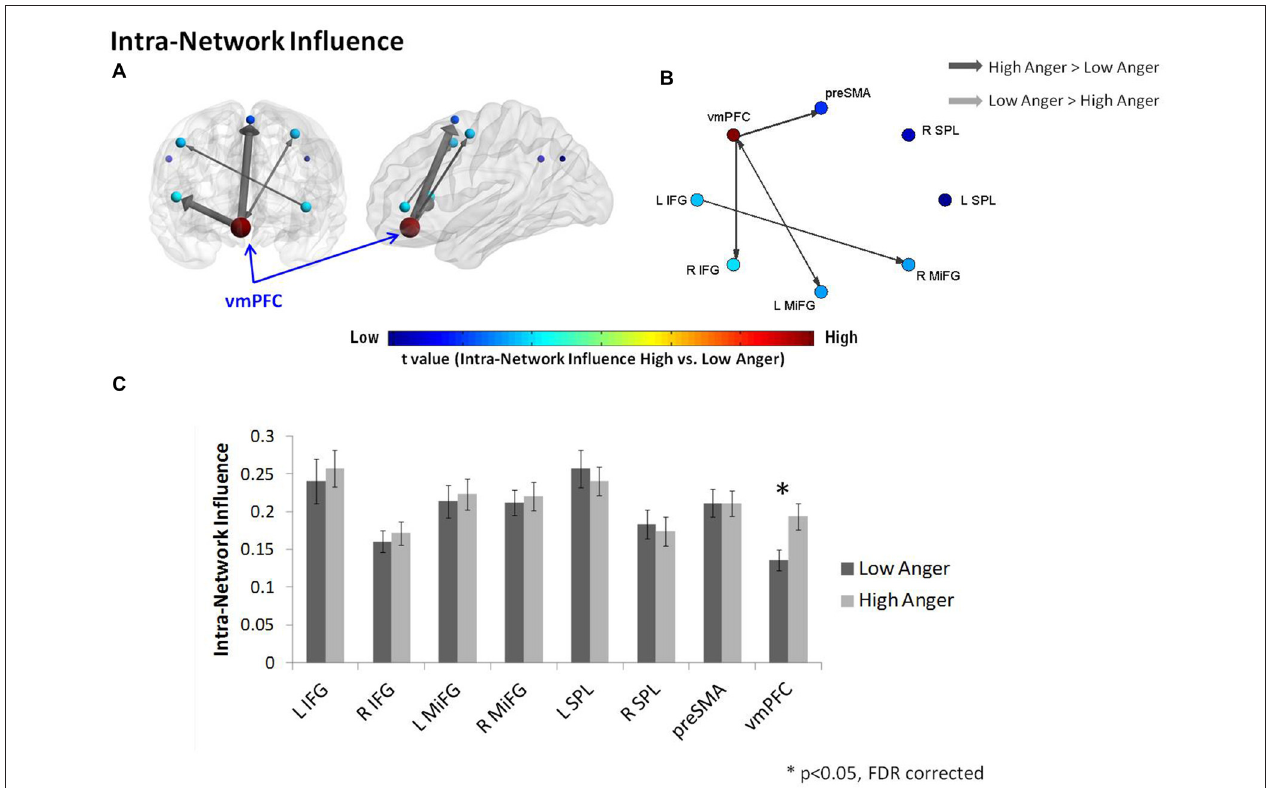
FIGURE 4 | Intra-regulation network results. The intra-network graph constructed for high anger minus low anger. The regulation network illustrated on sagittal and coronal views (A) and graphs visualization (B) . Each ROI was sized and color-coded according to its intra-network influence degree. Warmer colors and bigger sphere represent a more influential node. All pairwise ROIs with connections that were significant at the p < 0.05 level, using a t -test, are plotted as edges. The arrows indicate the direction of the influence, and the arrow size represents the t -statistic. (C) The nodes’ intra-network influence degree averaged over all 74 subjects. The vmPFC influence within the regulation network was significantly higher in the high anger condition vs. low